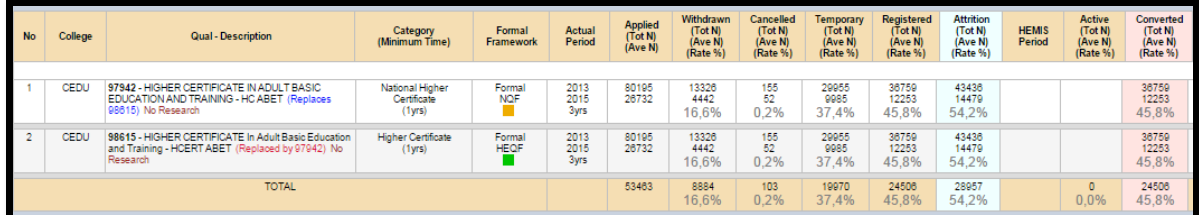
Figure 7. Attrition